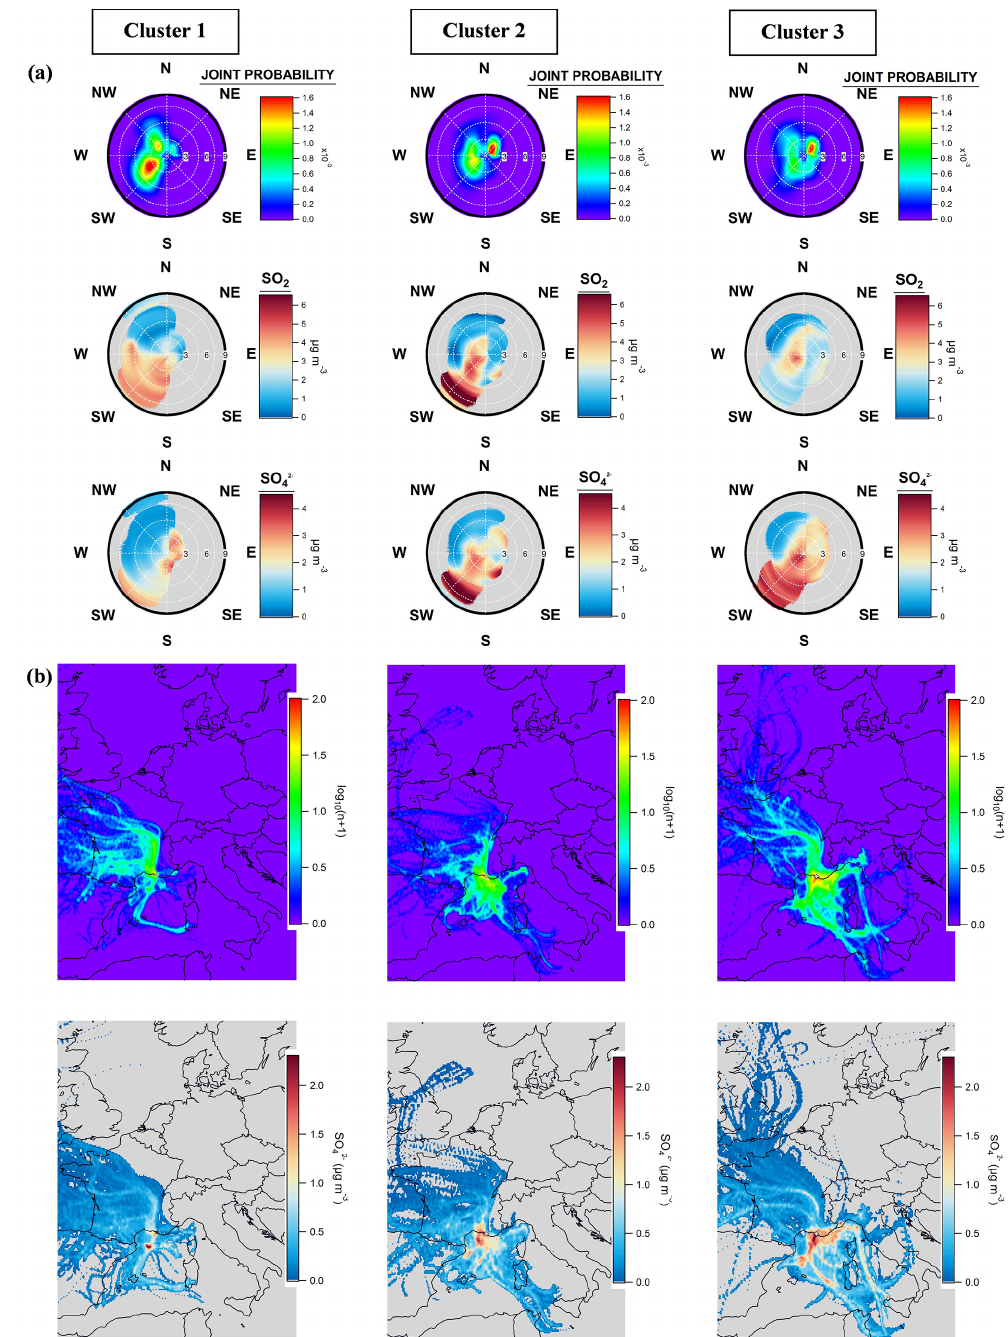
Figure 13. Joint probability distributions of winds (a) and NWR plots (b) of SO 2 and SO 2 − for 72h back trajectories (generated every hour at the MRS-LCP station) and CWT maps for SO 2 − three clusters (b) . The log 10 ( n + 1) colour scale corresponds to the occurrence of back-trajectory endpoints which drop into a particular cell. A discrete function based on log 10 ( n + 1) was applied to down-weight data with high concentrations but a low number of trajectories passing through a particular cell, as recommended by Waked et al. (2014). The aim was to avoid local sulfate influence from the transport model.